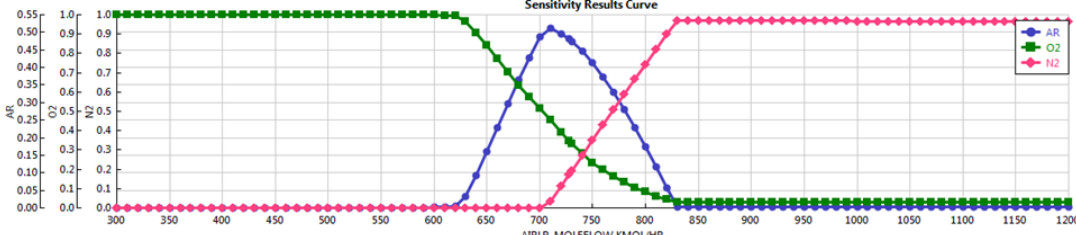
Figure 9. ARO2RECT molar fractions vs AIRLP mole flow rate.